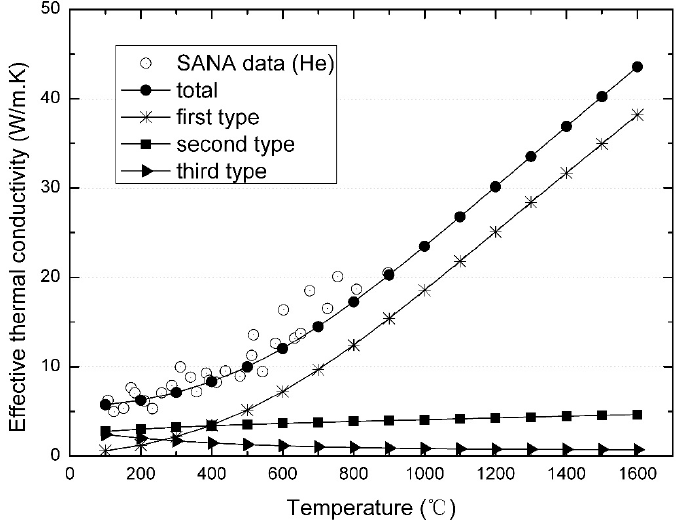
Figure 8. Total effective thermal conductivity of the pebble bed for helium conditions over the whole temperature range. temperature